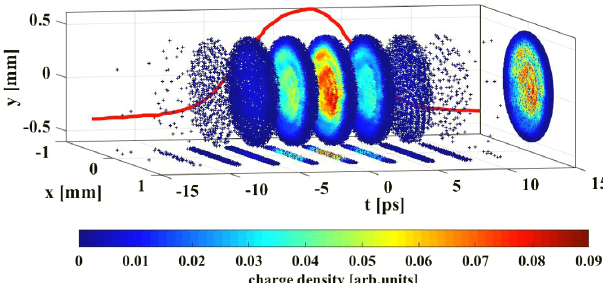
produced at photocathode using the measured cathode QE map and the measured transverse and temporal distributions of the cathode drive laser pulse.